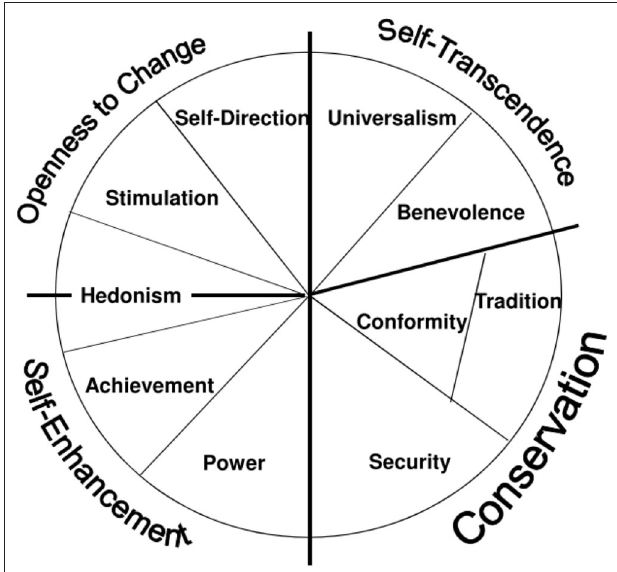
FIGURE 1 | Basic human values according to Schwartz